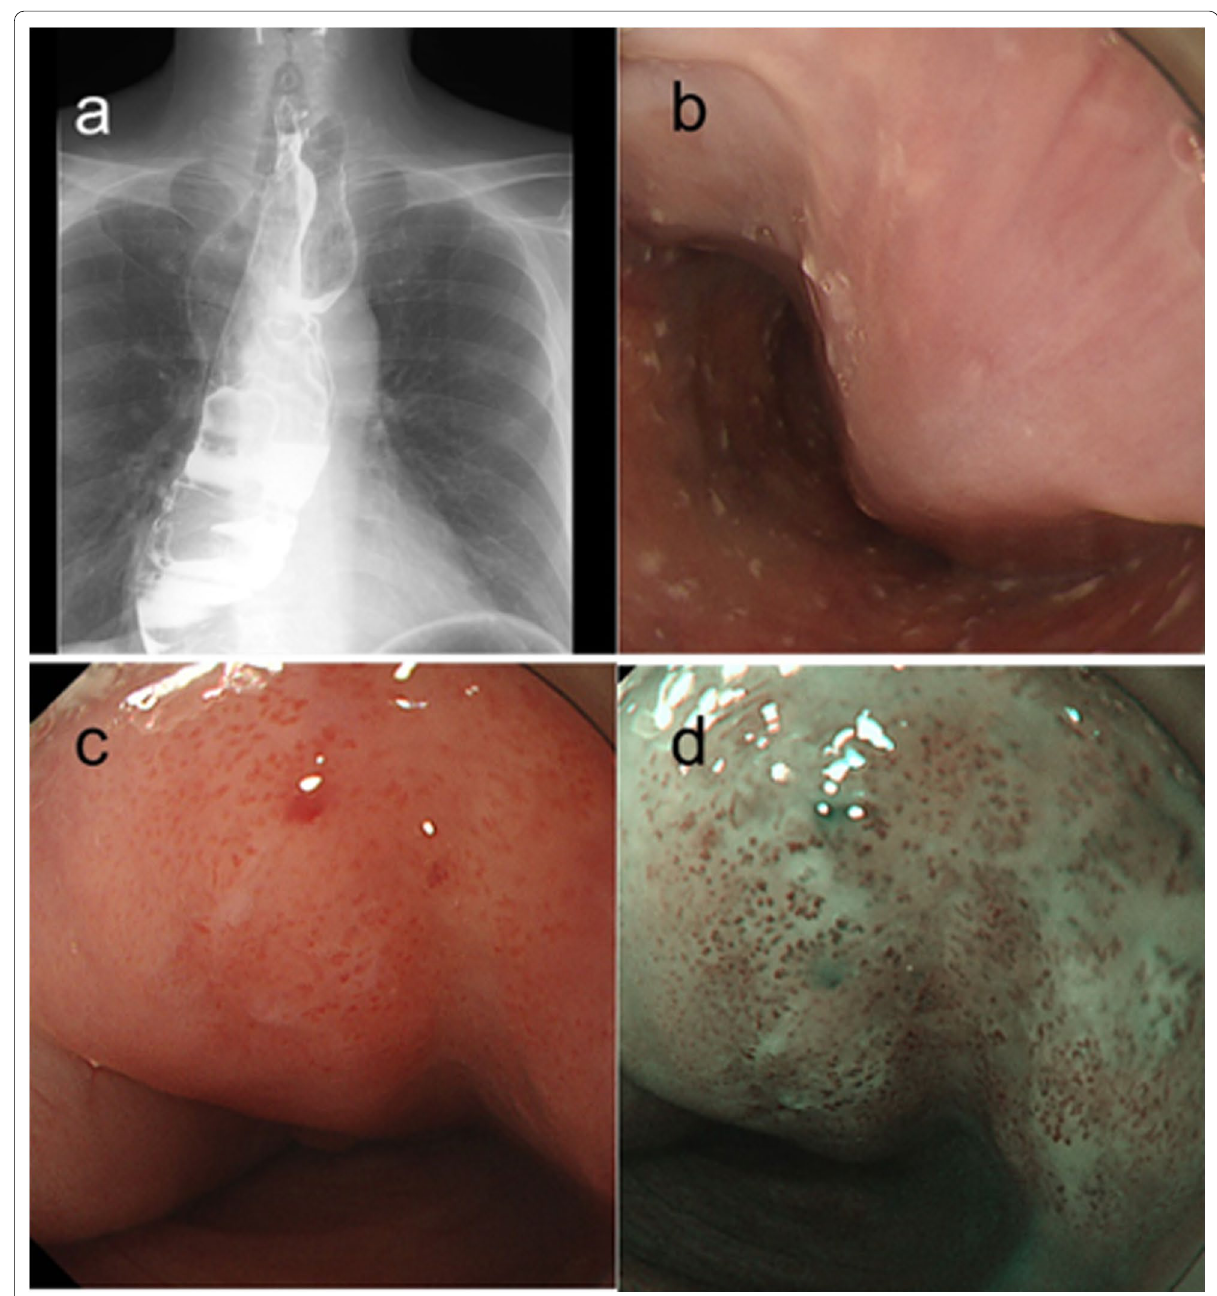
Fig. 1 Preoperative upper gastrointestinal imaging and esophagogastroduodenoscopy. a , b A giant tumor was seen, arising from the posterior wall of esophageal entrance and extending to the gastroesophageal junction, with the majority of the surface covered with normal mucosa. c , d There was a localized erythematous lesion on the tumor, and type B1 vessels were